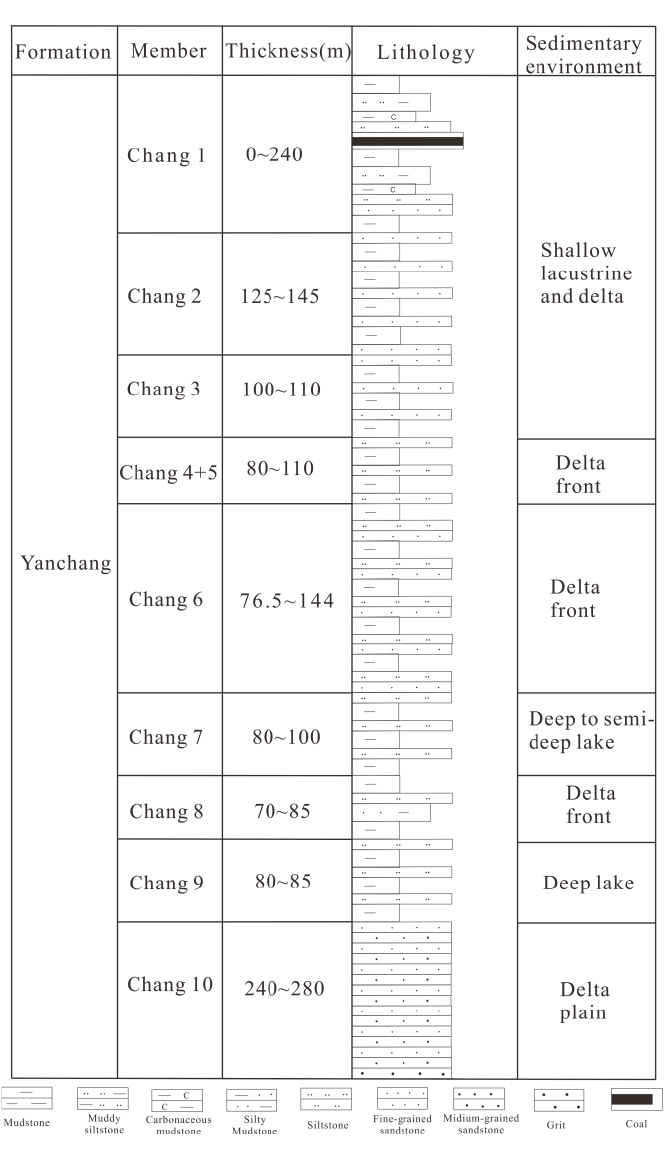
Figure 1. The location of research area.